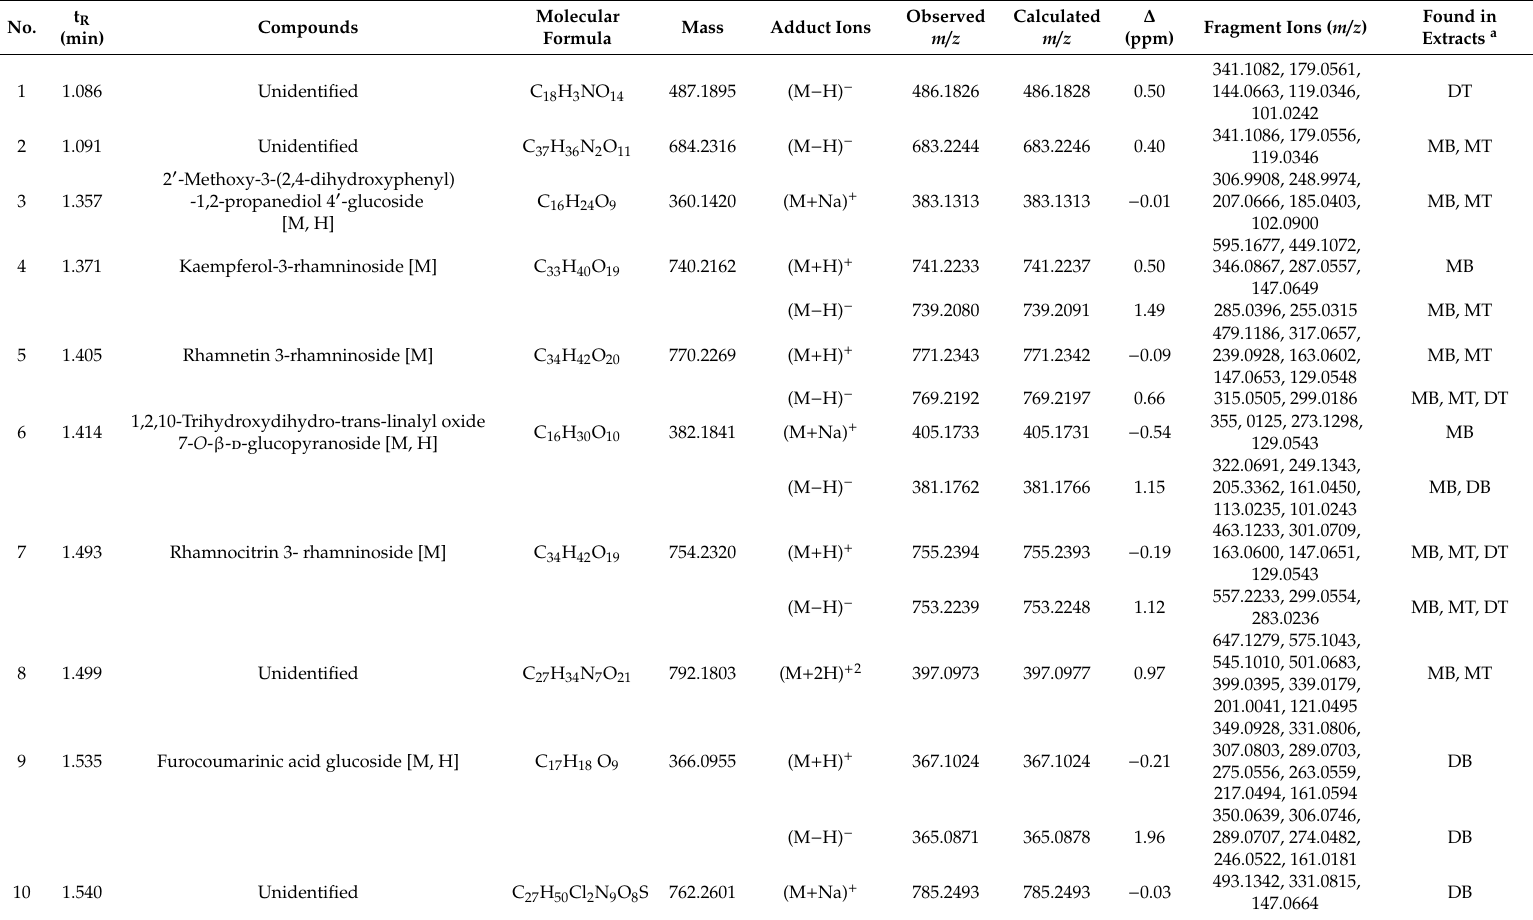
Table 1. Tentatively identified compounds in the bark and trunk of V. denticulata obtained from LC-MS / MS analysis. Compounds identified by Metlin Database [M], Human Metabolome Database [H] and standard compounds